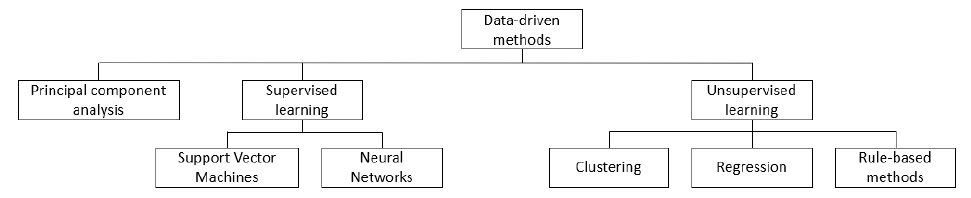
Figure 1. Tree of research.